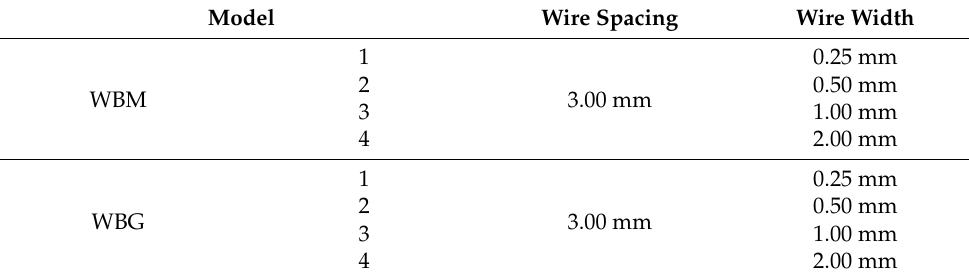
Table 2. Dimensional parameters of coils in WBM and WBG EMATs.